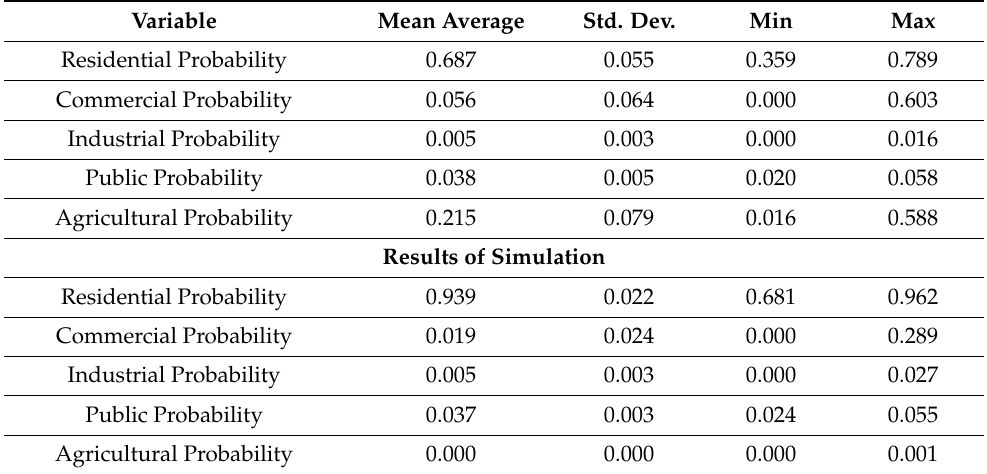
Table 5. Change in probabilities of use following the re-categorization of areas of expansion to urban.